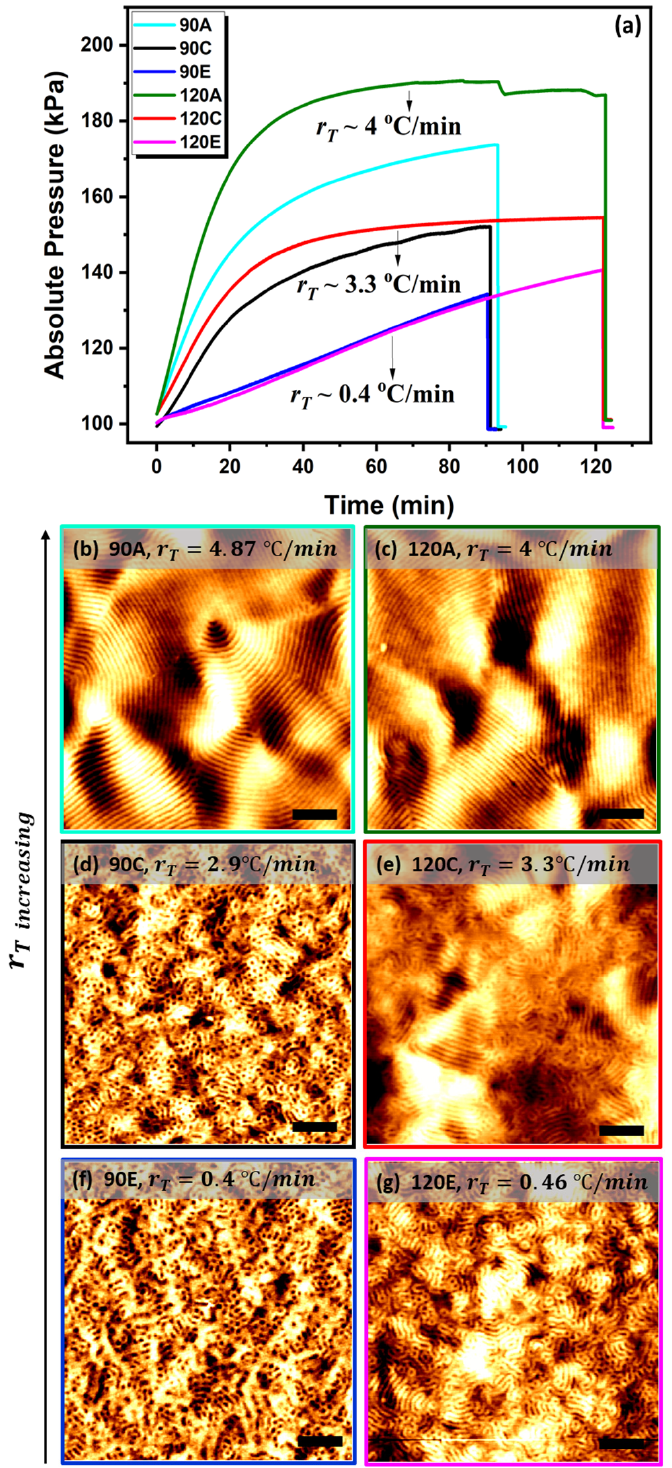
Figure 3. The significance of pressure ramp over the length of the annealing time . Absolute vapour pressure ( a ) and relevant AFM images ( b – g ) for the films annealed in oven at different ramps for 90 min (samples 90A ( b ), 90C ( d ), 90E ( f )) and 120 min (samples 120A ( c ), 120C ( e ), 120E ( g )). AFM scale bars are 300 nm. At low heating ramp, increasing the annealing time does not appear to improve the